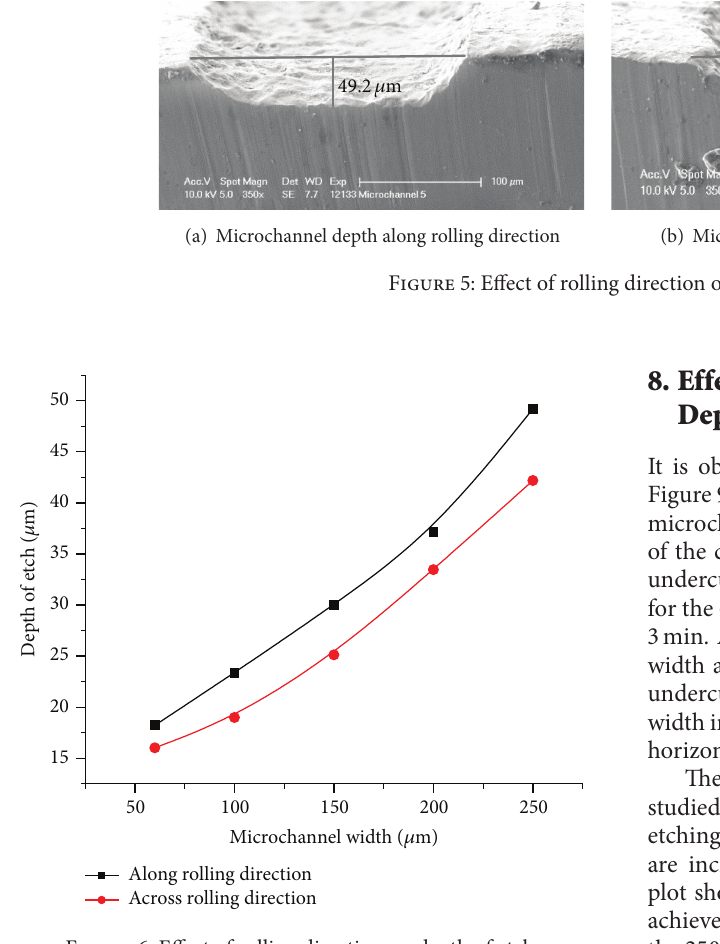
Figure 6: Effect of rolling direction on depth of etch.